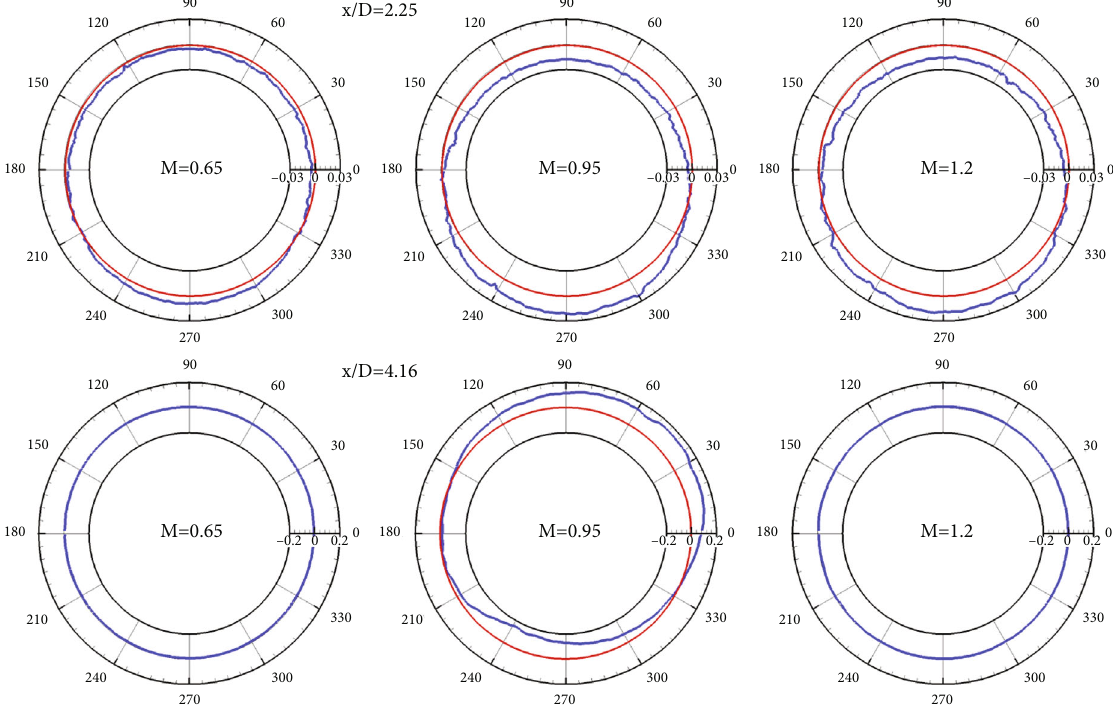
Figure 11: Pressure coe ffi cient di ff erence(blue line) between A : O : A : = 2 : 5 and 0.0 at two di ff erent (0.65, 0.95, and 1.2) in Figure 11. The blue line corre-